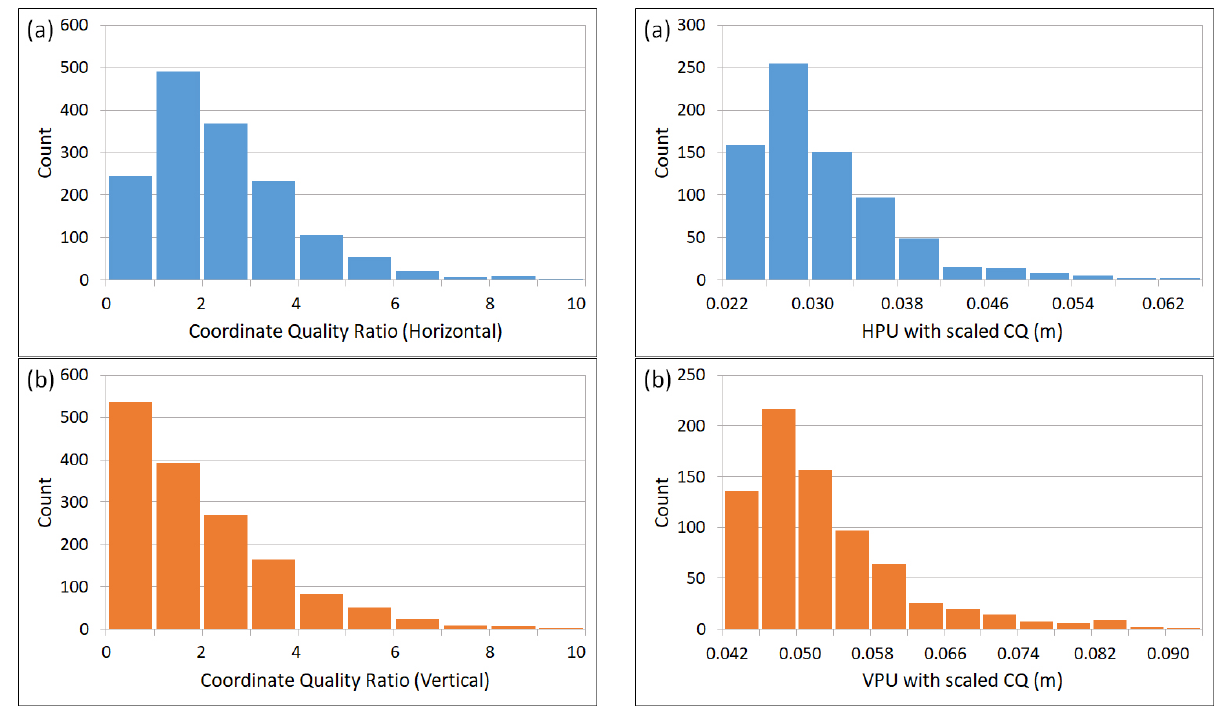
Fig. 4. Ratio of measured coordinate quality to reported CQ output for the (a) horizontal and (b) vertical components.